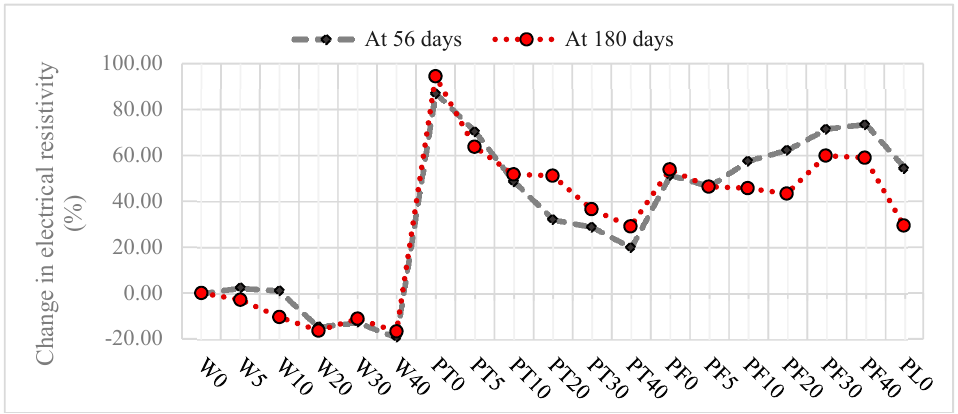
Figure 16. Change in ER of all mixes relative to the reference concrete (W0).